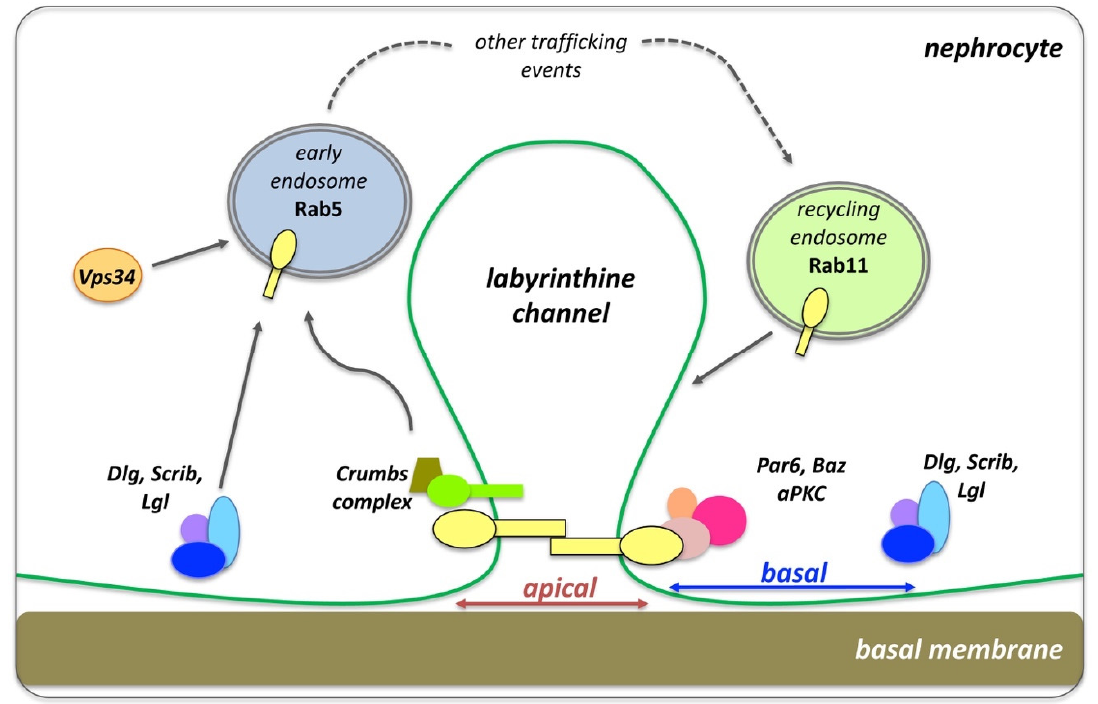
Figure 6. The slit diaphragm (SD), endocytosis and polarity establishment in Drosophila nephrocytes. The apical polarity Crumbs and PAR complexes localize at the SD, which corresponds to the apical region of the nephrocytes. Dlg, Scrib and Lgl localizes to the basal side the nephrocytes, flanking neighboring SDs. Cell trafficking, including early endosomes and recycling endosomes, are critical for the function of the SD and proper endocytic function (diagram adapted with modifications from Ref. [179] ).